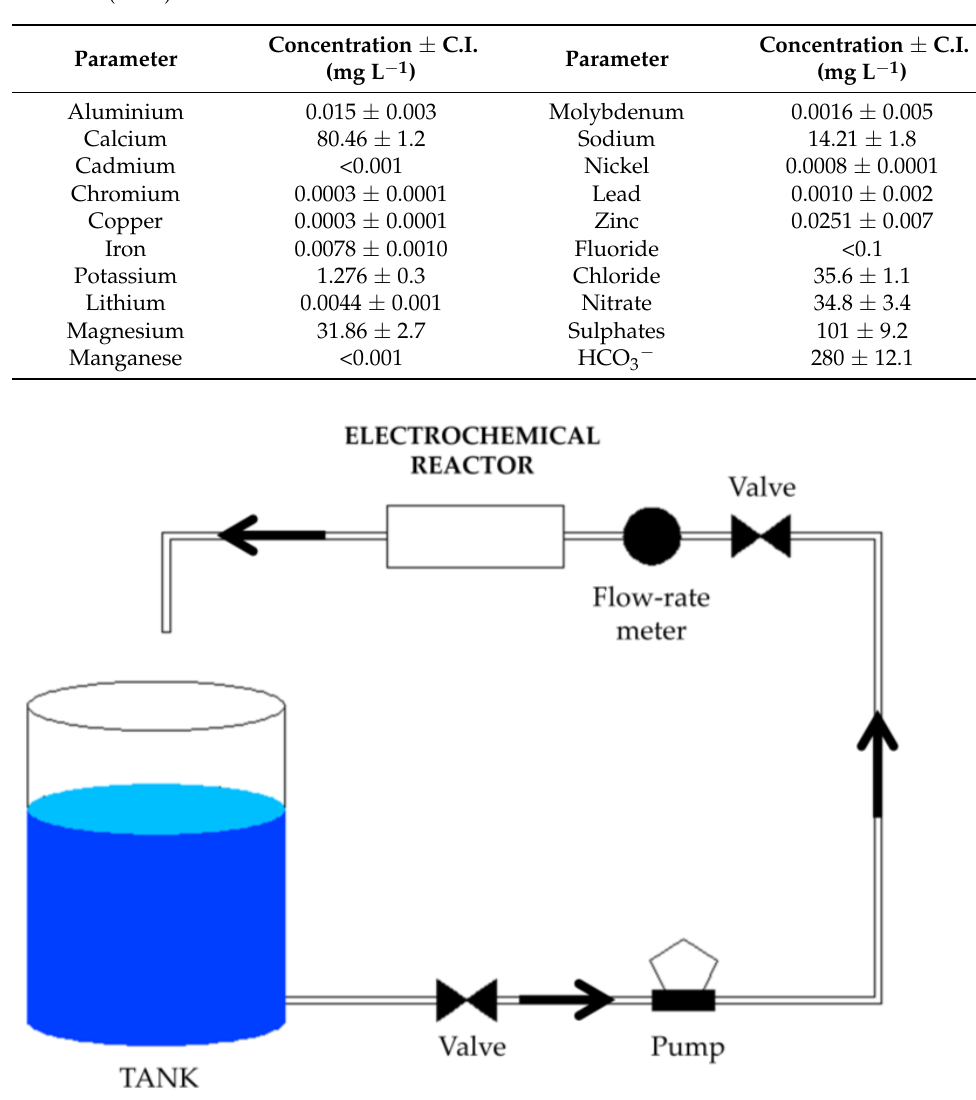
Table 1. Analytical characterization of the tap water used for preparing arsenic-containing water